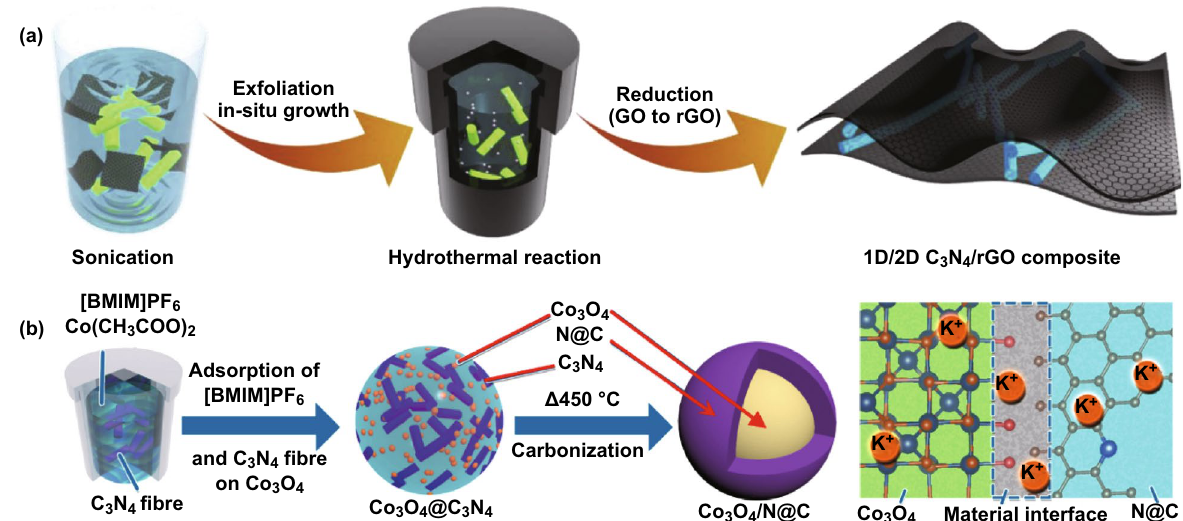
Fig. 14 a Schematic illustration of the synthesis of 1D/2D C 3 N 4 /rGO composite via a hydrothermal/freeze-drying method. Reproduced with permission from Ref. [54]. b Scheme illustrating suggested potassiation and depotassiation mechanism of the Co 3 O 4 @N–C electrode. Repro- duced with permission from Ref. [108]. Copyright permission from Elsevier and American Chemical Society. (Color figure